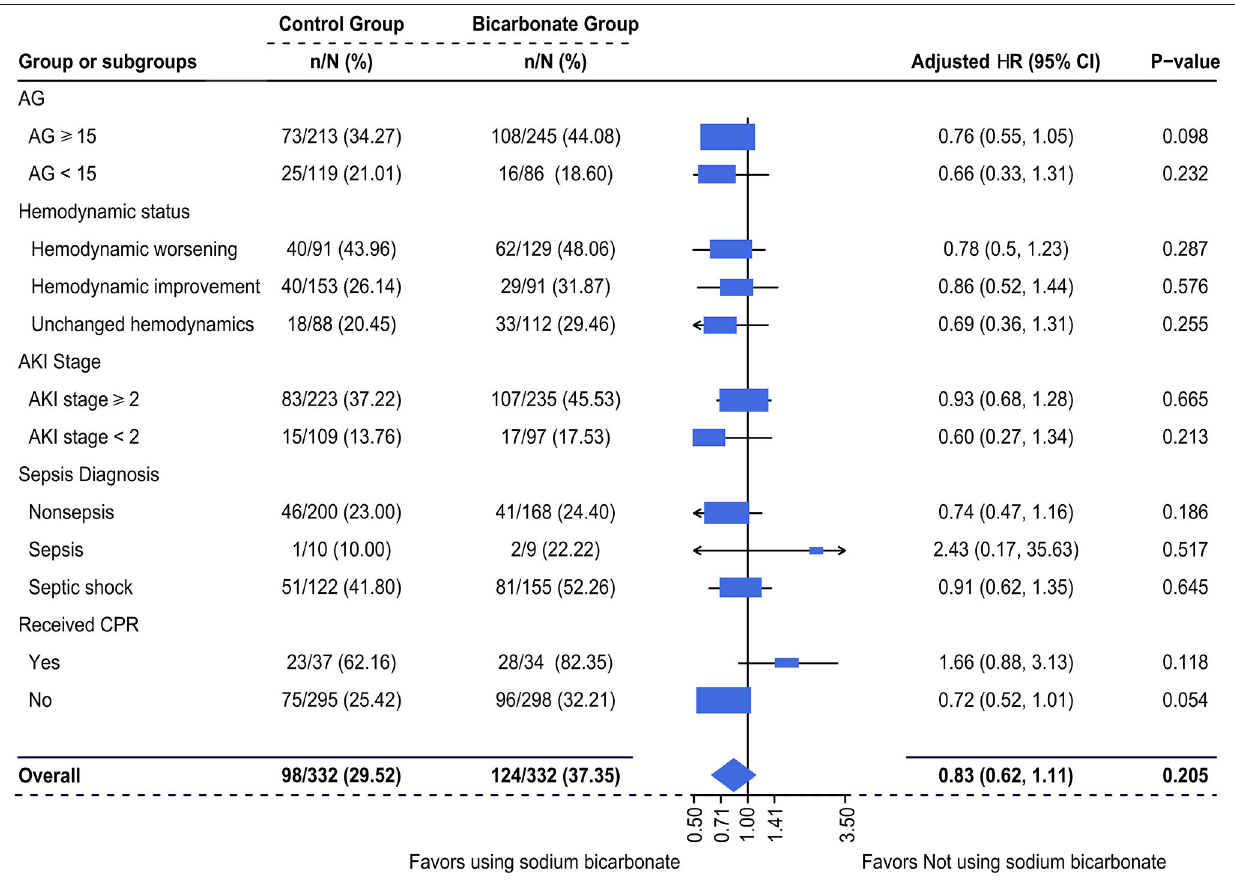
FIGURE 5 | Multivariable-adjusted hazard ratios (HRs) of SBT for 28-day mortality. Multivariate Cox regression was used. We adjusted variables including (1) mechanical ventilation within 48h after ICU admission, (2) sepsis diagnosis, (3) ketoacidosis diagnosis, (4) CPR, (5) cumulative fluid balance within 48h after ICU admission, (6) SOFA score during the first 24h after ICU admission, and (7) pH-value. d/eOD, developed or exacerbated organ dysfunction; AKI, acute kidney injury; AG, anion gap; CPR, cardiopulmonary